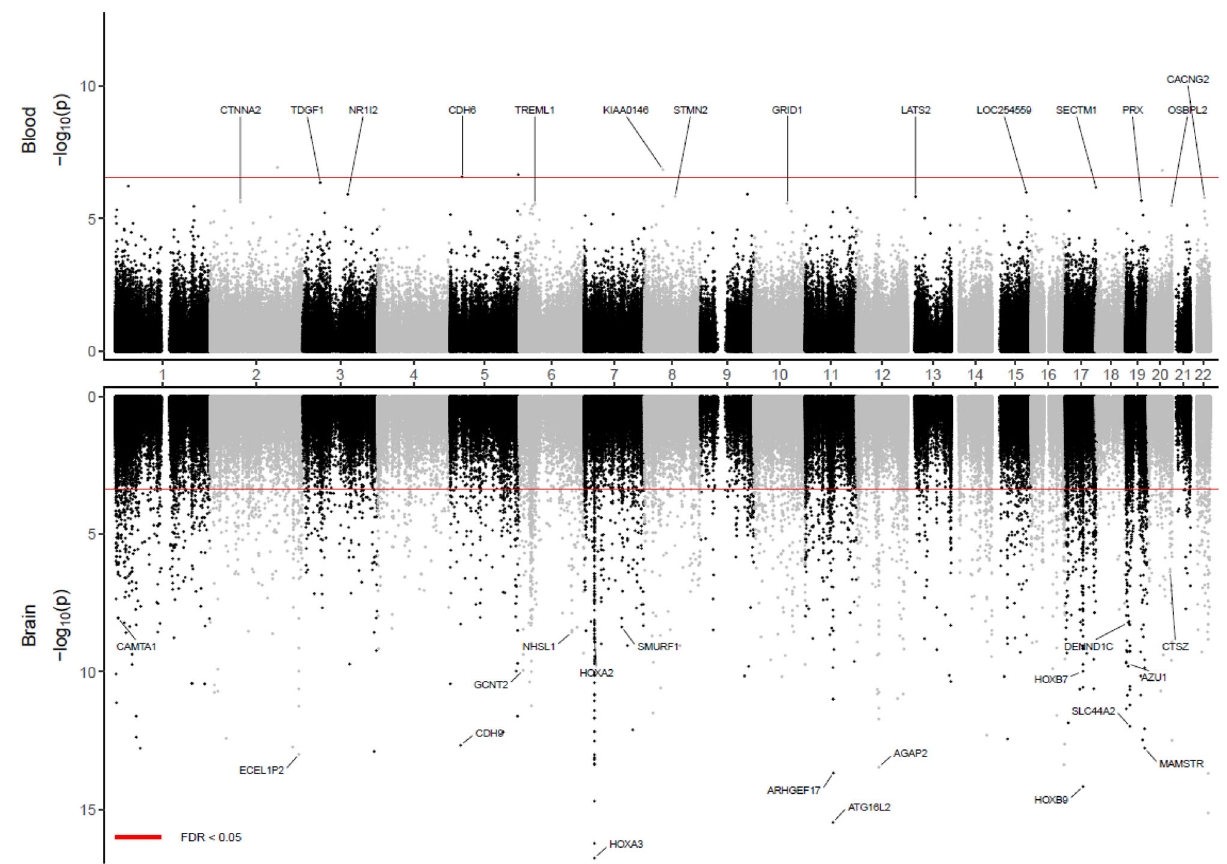
Fig.1|Miamiplotforepigenome-widemeta-analysisofbloodDNAmethylation in ADNI and AIBL datasets. The X-axis shows chromosome numbers. The Y-axis shows – log 10 ( P- value) of methylation to AD diagnosis association in the blood (above X-axis) or methylation to AD neuropathology (Braak stage) association in the brain (below X-axis). The genes corresponding to the top 20 most signi fi cant